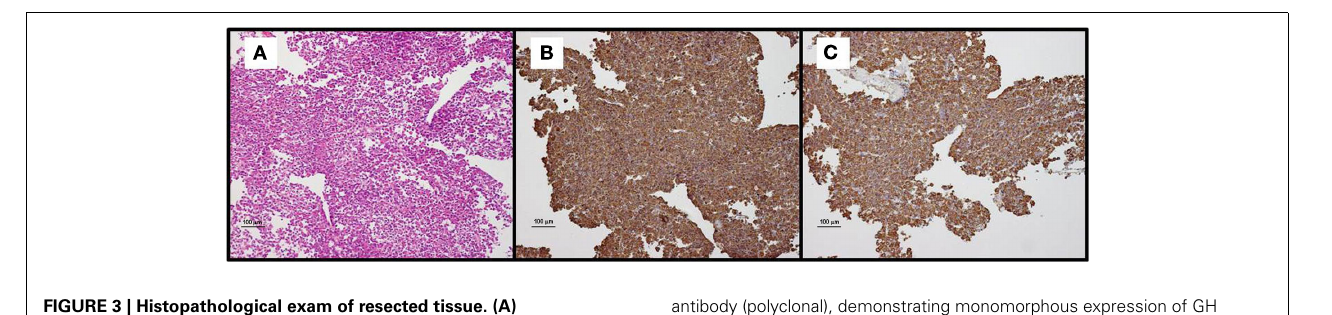
FIGURE 3 | Histopathological exam of resected tissue. (A) Hematoxylin-eosin staining (Magnification × 10): pituitary adenoma composed of round to polygonal cells with abundant eosinophilic or granular cytoplasm.The cells are arranged in solid nests or trabeculae. (B) Immunohistochemical analysis (Magnification × 10) with an anti-GH